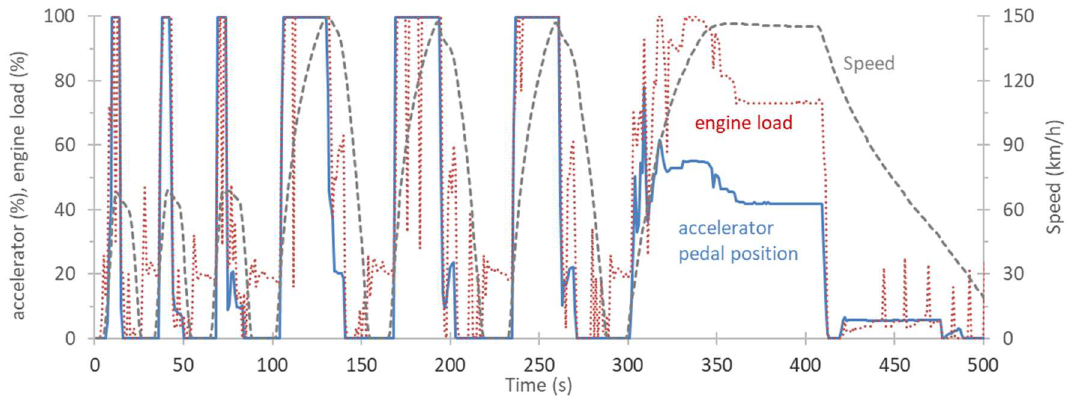
Figure A2. Accelerator pedal position and engine load for the US06 test at −4 °C.